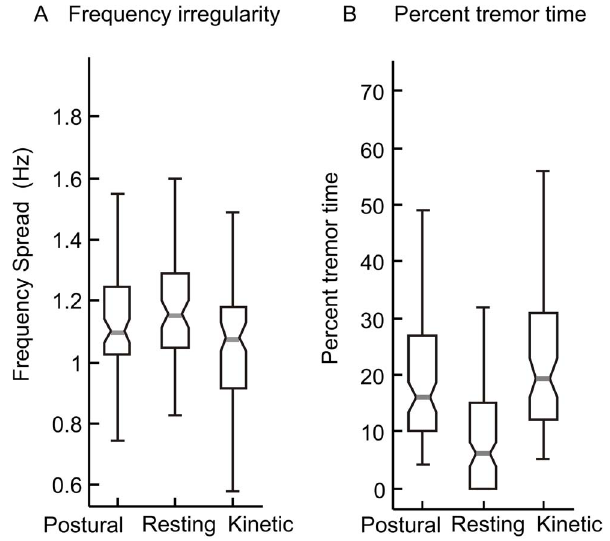
Figure 4. Comparison of the frequency irregularity and percent tremor time during postural, resting, and kinetic tremor in 79 A–T subjects. Each box-whisker plot depicts one condition. Grey horizontal line depicts median frequency spread (A) or percent time (B), notches correspond to 95% confidence interval, box-lengths depict quartile values, and whiskers depict range.